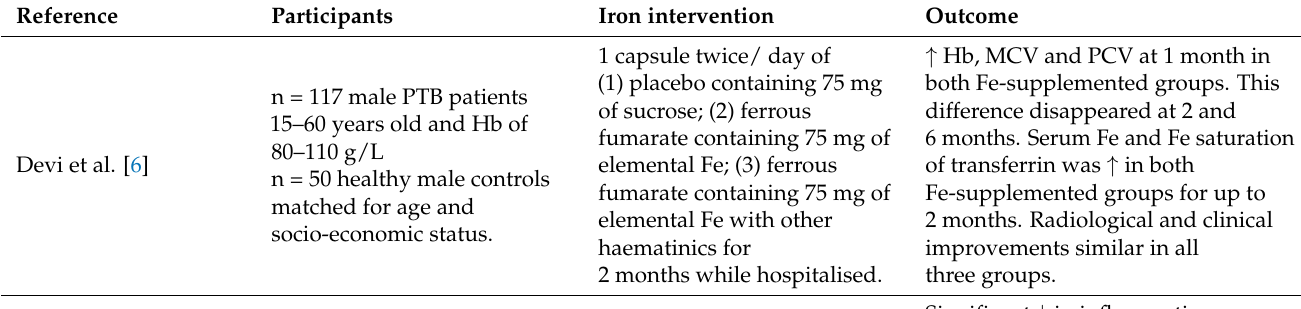
Table 3. Clinical studies investigating iron supplementation in TB